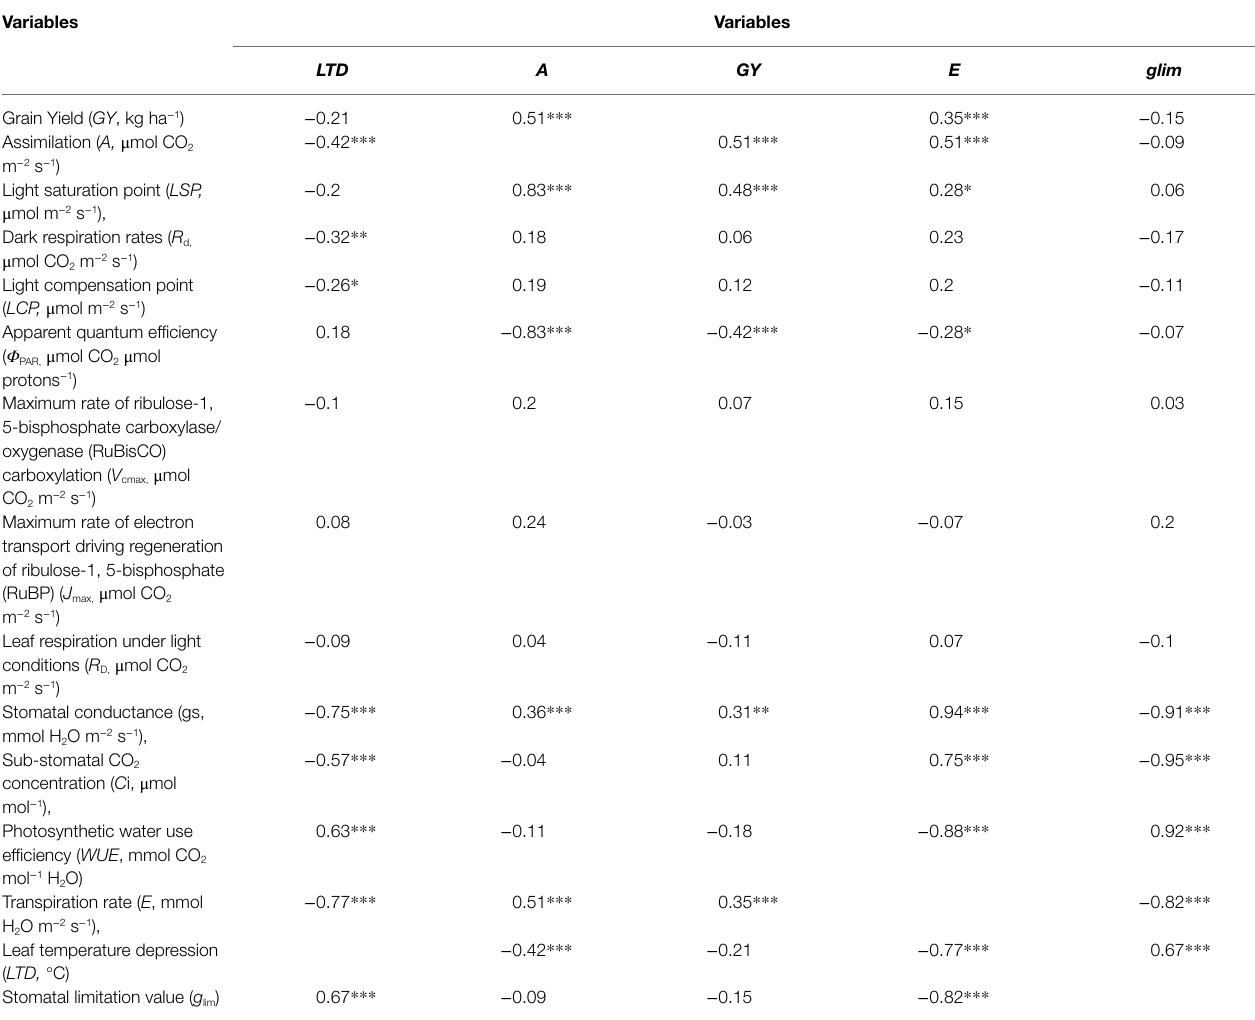
TABLE 1 | Correlation coefficients (r) between grain yield ( GY ), assimilation ( A ), leaf temperature depression ( LTD ), transpiration ( E ) and stomatal limitation ( g lim ) values and physiological traits at the leaf level of 64 genotypes of bean grown under conditions of high temperature.